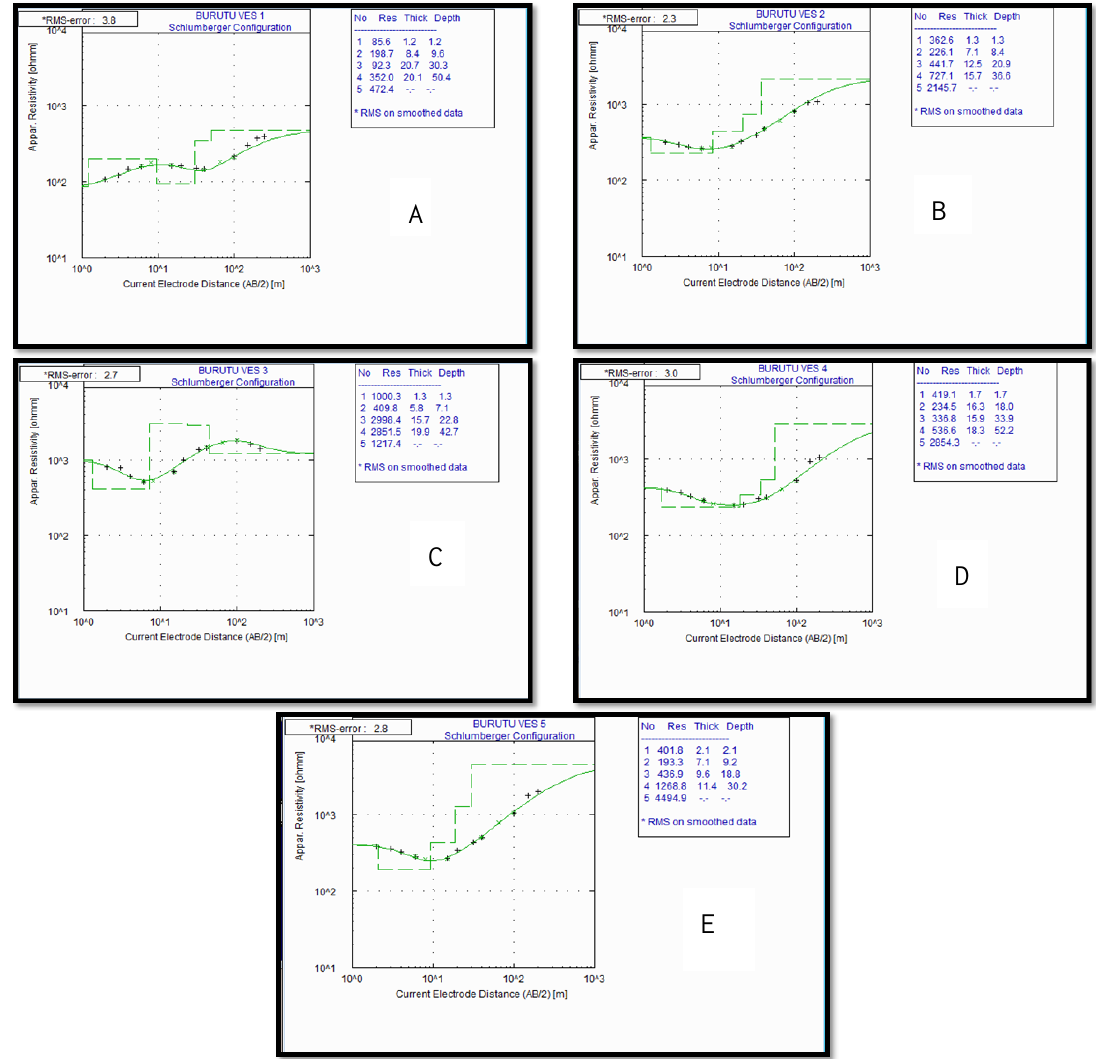
Figure 7. ( A – E ) Representative samples of computer iterated curves and theirs inverted models depicting resistivity values, geoelectric layers and depths.